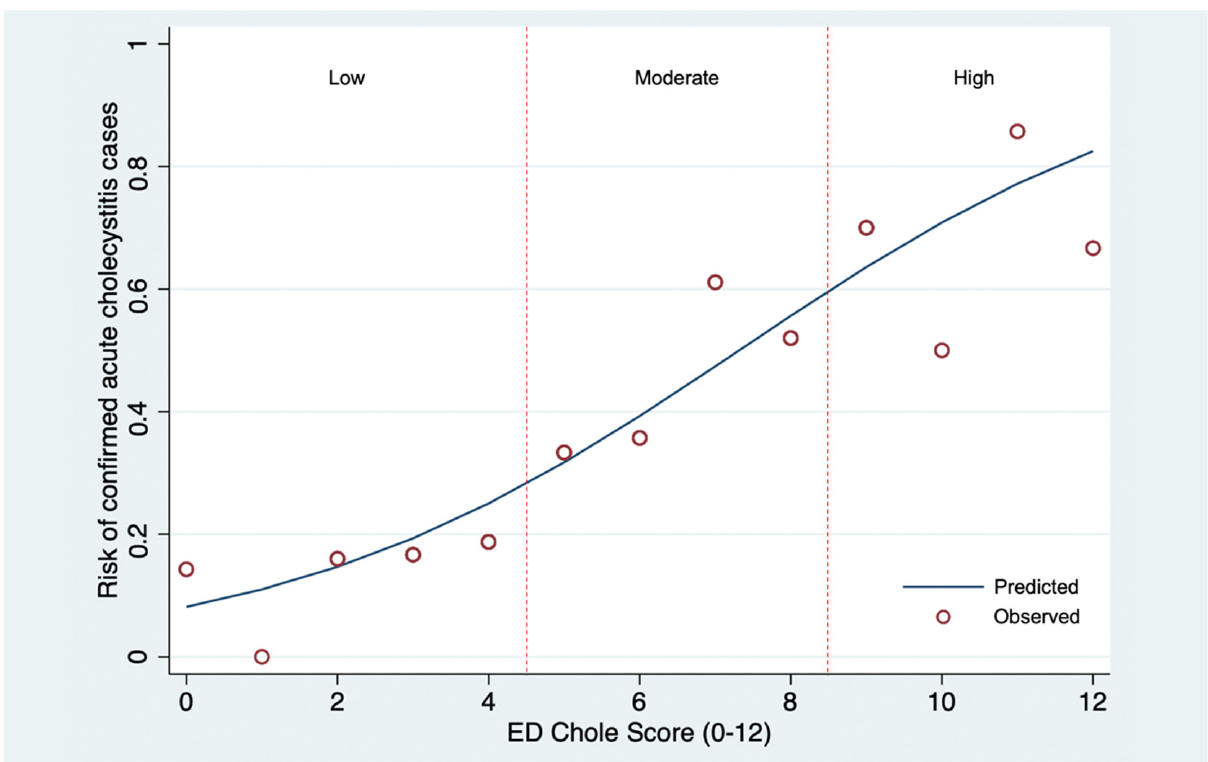
Figure 3. Calibration plots visualizing agreement between the derived score (ED Chole Score) and the actual (observed) risk. The blue line depicts the predict risk of acute cholecystitis confirmed cases. The red circle defines the observed risk of acute cholecystitis confirmed cases.